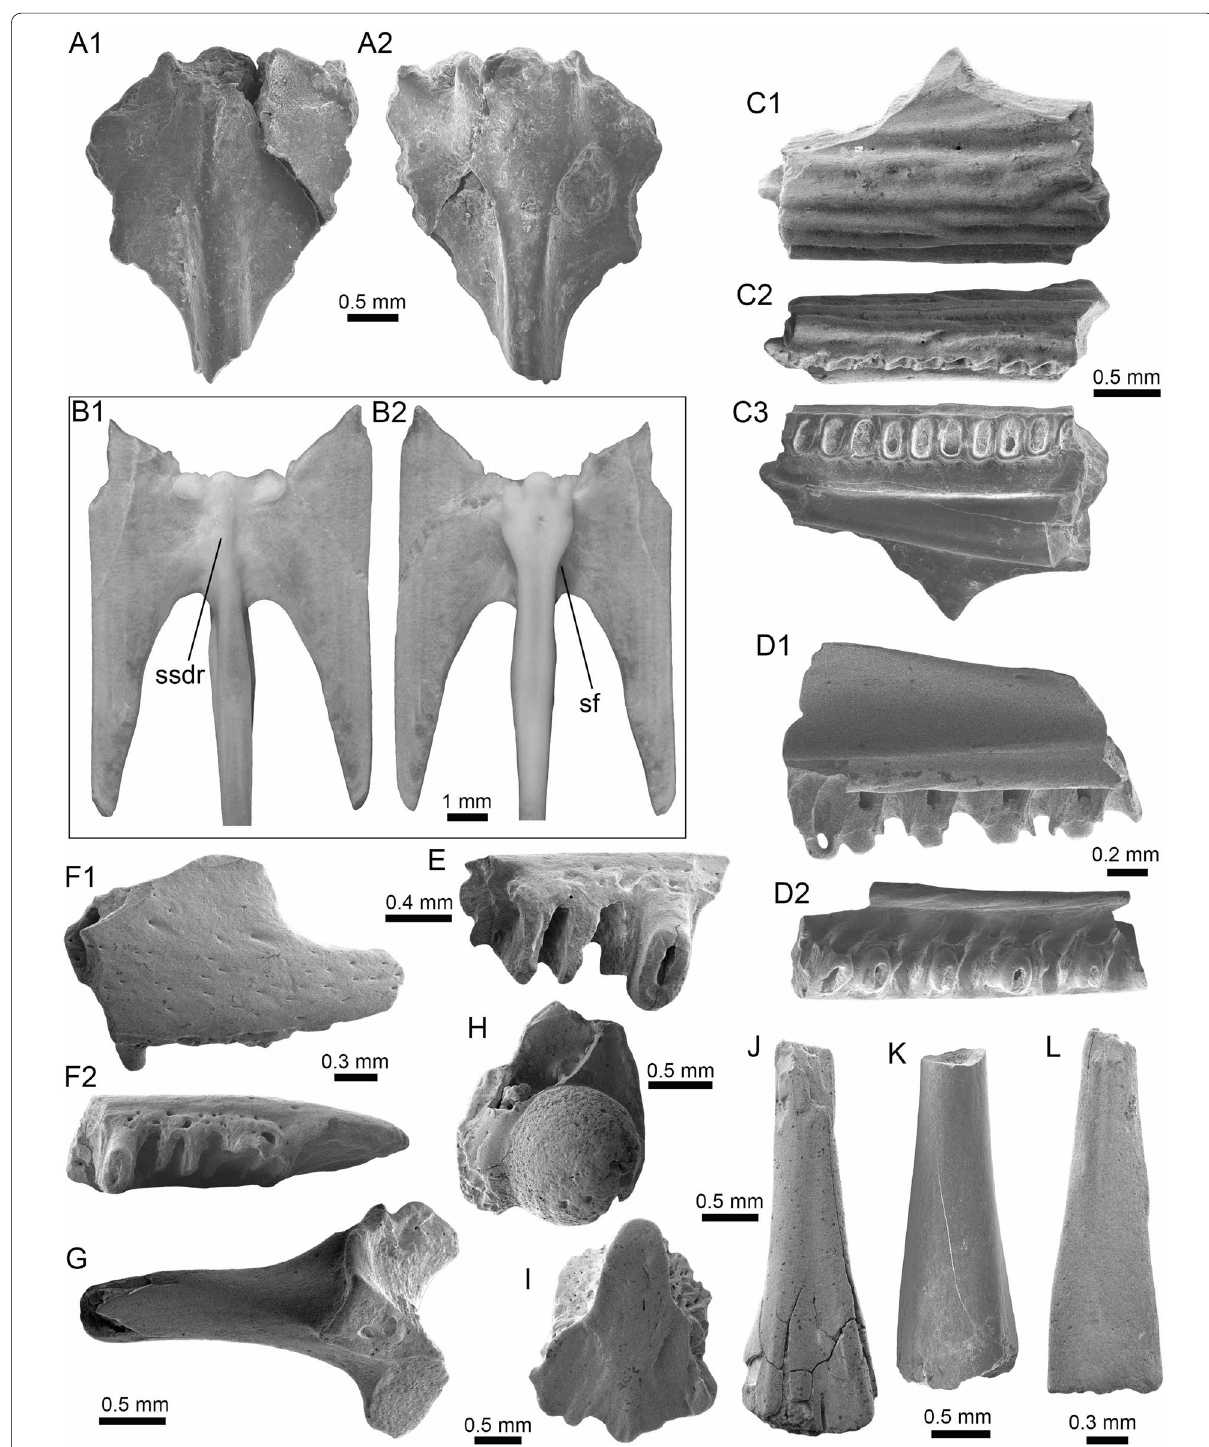
Fig. 14 Anura from the Vergel Member. A1 , A2 Incomplete fused sacral vertebra of cf. Pipa sp. (AMU‑CURS‑722). B1 , B2 Sacral vertebra of recent Pipa parva (PIMUZ A/II 118). C1 – L Anura indet. C1 – F2 Maxilla fragments ( C1 – C3 AMU‑CURS‑1177, D1 , D2 AMU‑CURS‑1149, E AMU‑CURS‑1166 and F1 , F2 AMU‑CURS‑1165). G Distal fragment of a left ilium (AMU‑CURS‑1150). H Distal portion of left humerus (AMU‑CURS‑1152). I Spinous process of and incomplete trunk vertebra (AMU‑CURS‑1153). J Distal fragment of a right radioulna (AMU‑CURS‑1151). K , L Indeterminate limb bone fragments (AMU‑CURS‑807). Views: dorsal ( A1 , B1 , I , ? J ), left lateral ( G ), right lateral ( F1 ), lateral ( C1 , D1 ), lateroventral ( C2 ), ventral ( A2 , B2 , C3 , D2 , E , F2 , H ), and indet. ( K , L ). ssdr sacral sagittal dorsal ridge, sf spinal